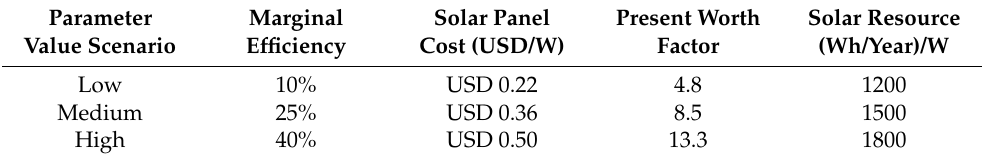
Table 5. MLCOE input parameter ranges for calculation of the cost distribution for DDS SEC.